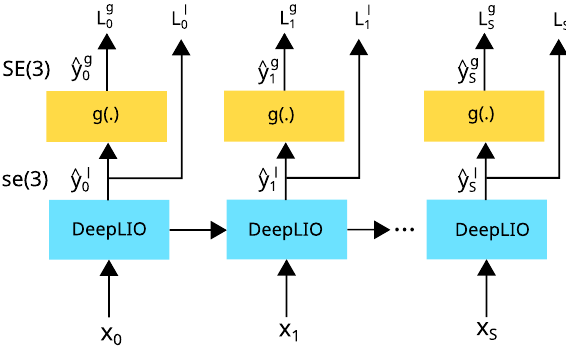
Figure 3. Schematic representation of the local and global loss calculated based on the local predictions of DeepLIO given a sequence of input